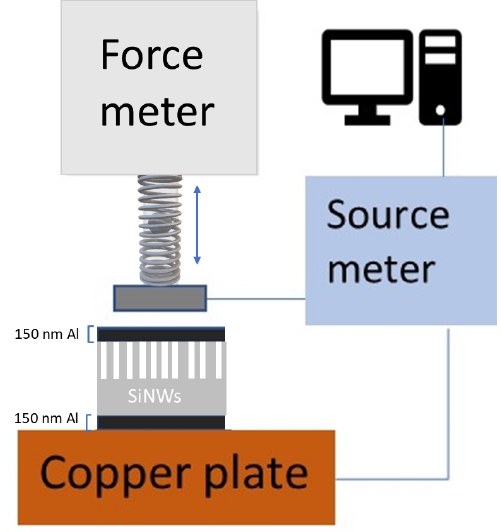
Figure 3. Schematic of the force meter setup for testing PZR